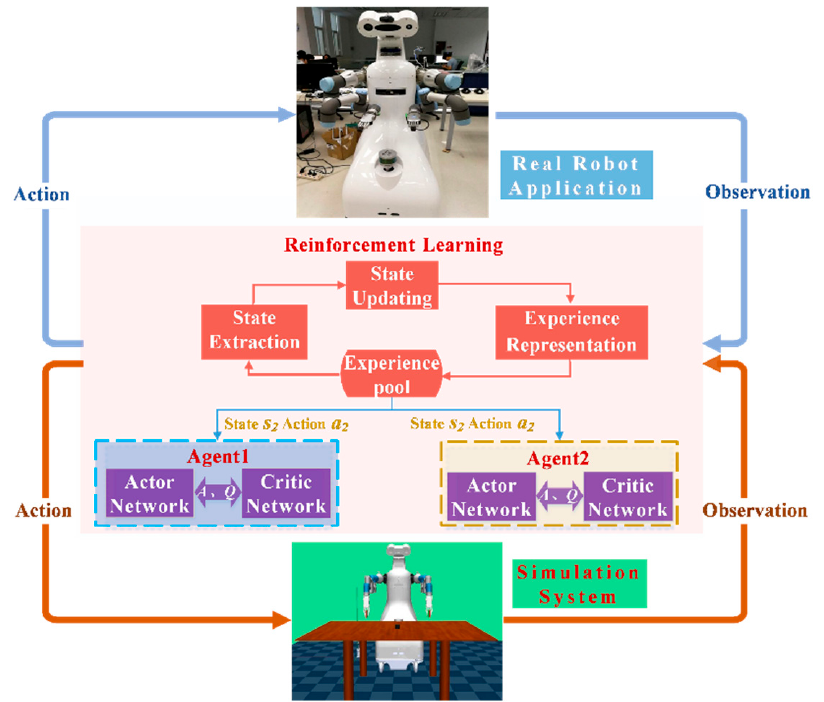
Figure 6. The algorithm transferring architecture. The simulation condition is replaced by the physical environment on the basis of the equivalence principle.